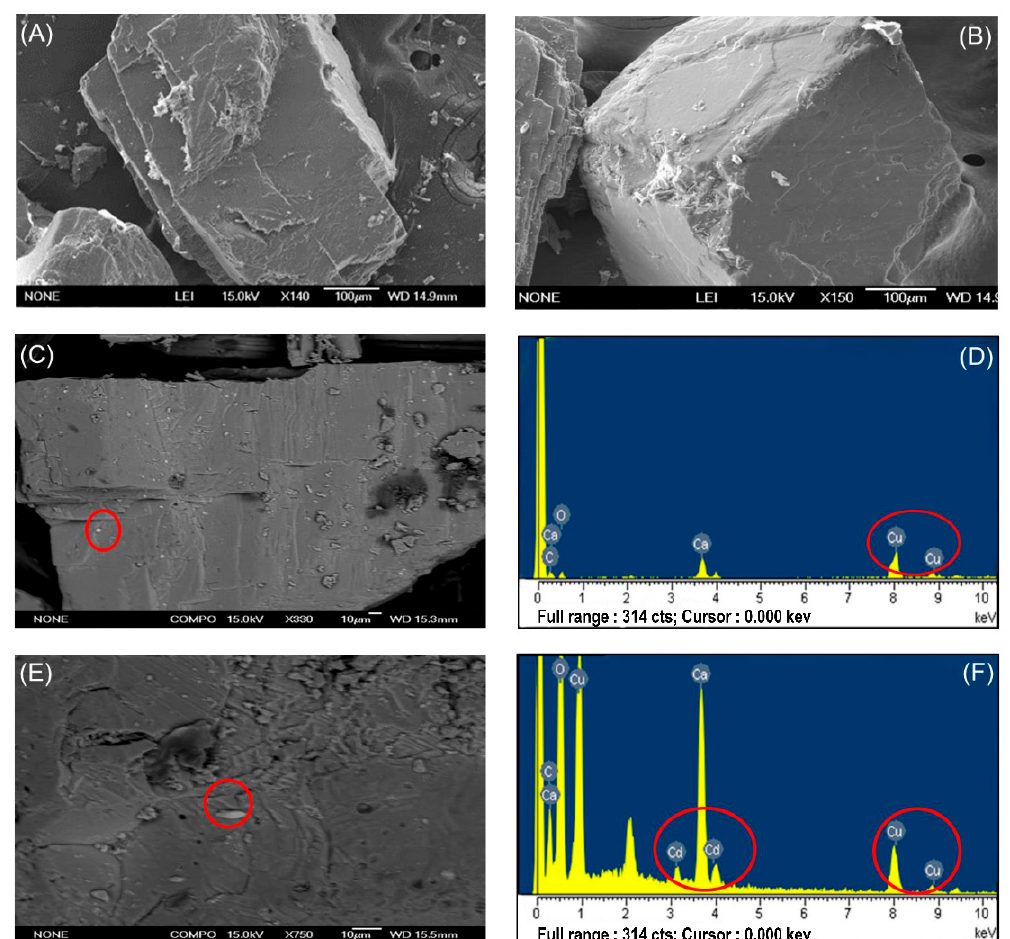
Figure 4. Scanning electron microscopy (SEM) and energy-dispersive X-ray spectroscopy (EDS) spectra of quartz sand under different migration conditions: ( A ) original sample prior to the experiment; ( B ) EPS breakthrough; ( C , D ) breakthrough of EPS + Cu and the corresponding EDS spectra; ( E , F ) breakthrough of EPS + Cu + Cd and the corresponding EDS spectra.